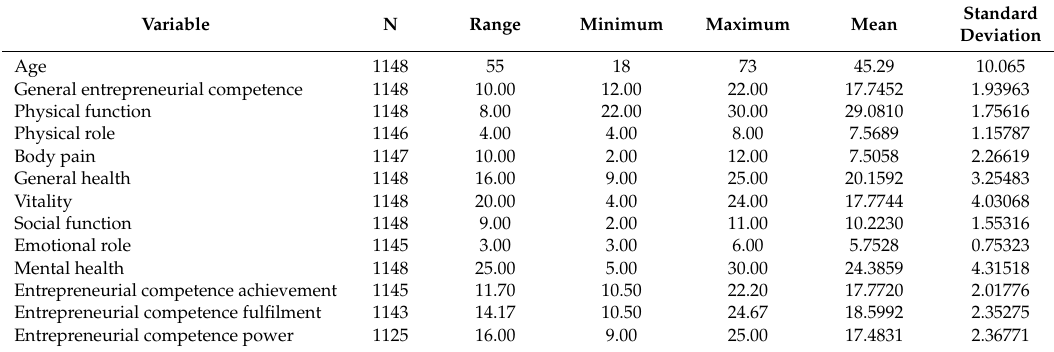
Table 2. Descriptive statistics of the study variables.